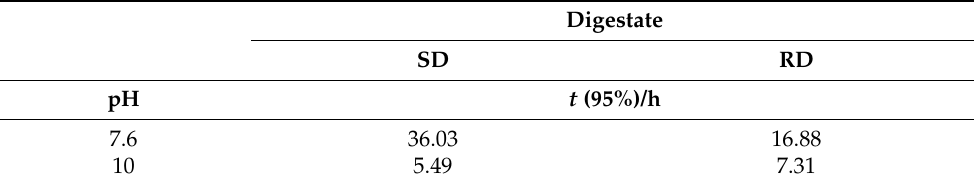
Table 2. Time needed to reach 95% NH 3 recovery for the PTFE-0.22 membrane operated with a